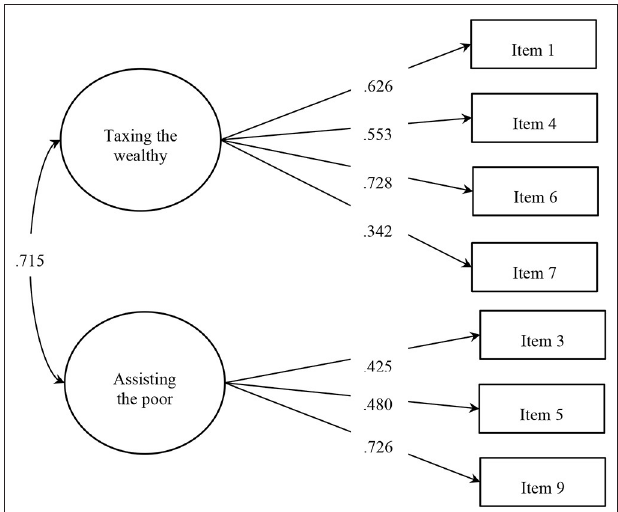
FIGURE 1 | Dimensions of support for redistribution (standardized factor